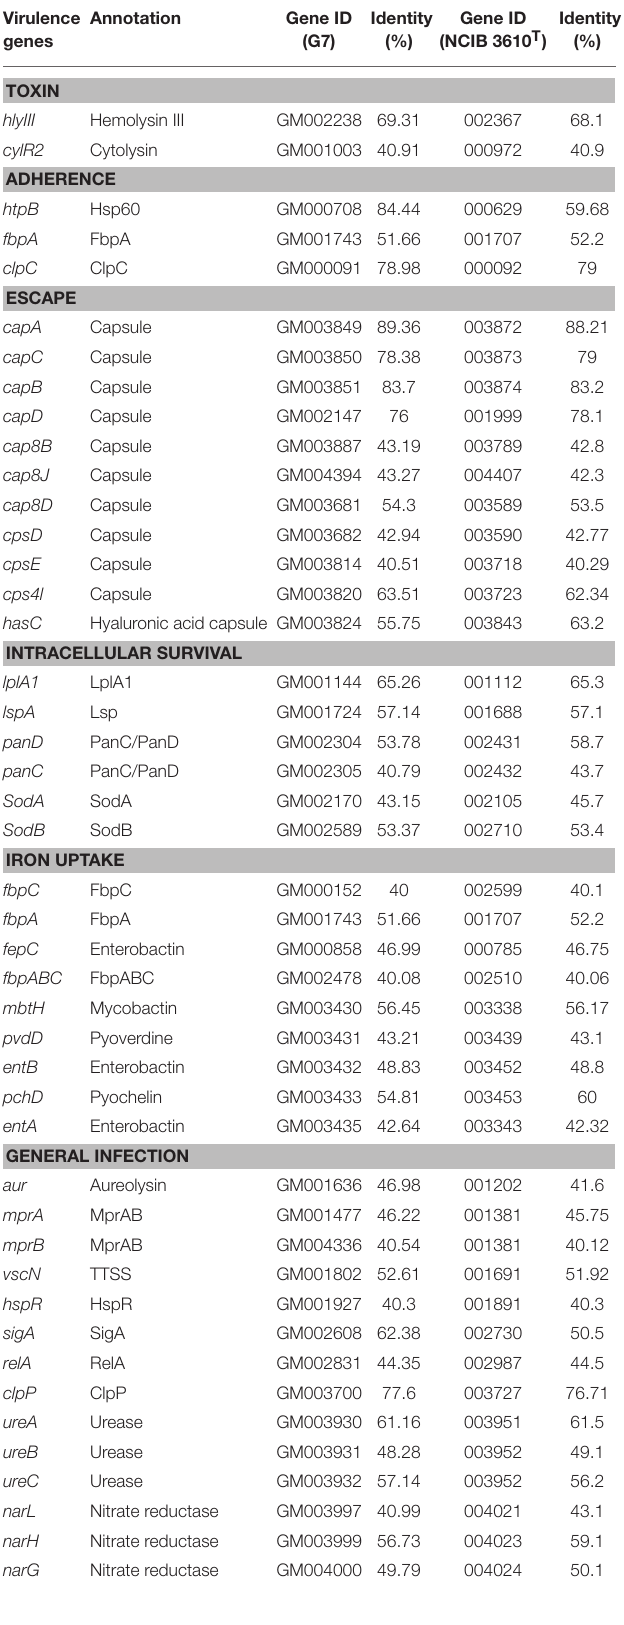
TABLE 2 | Putative virulence factors of strain G7 and NCIB 3610 T